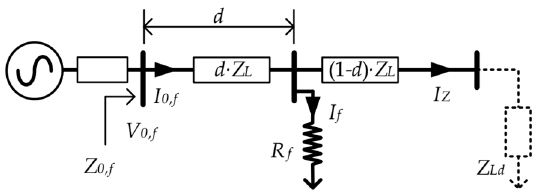
Figure 14. Basic operating principle of impedance-based location method [8].